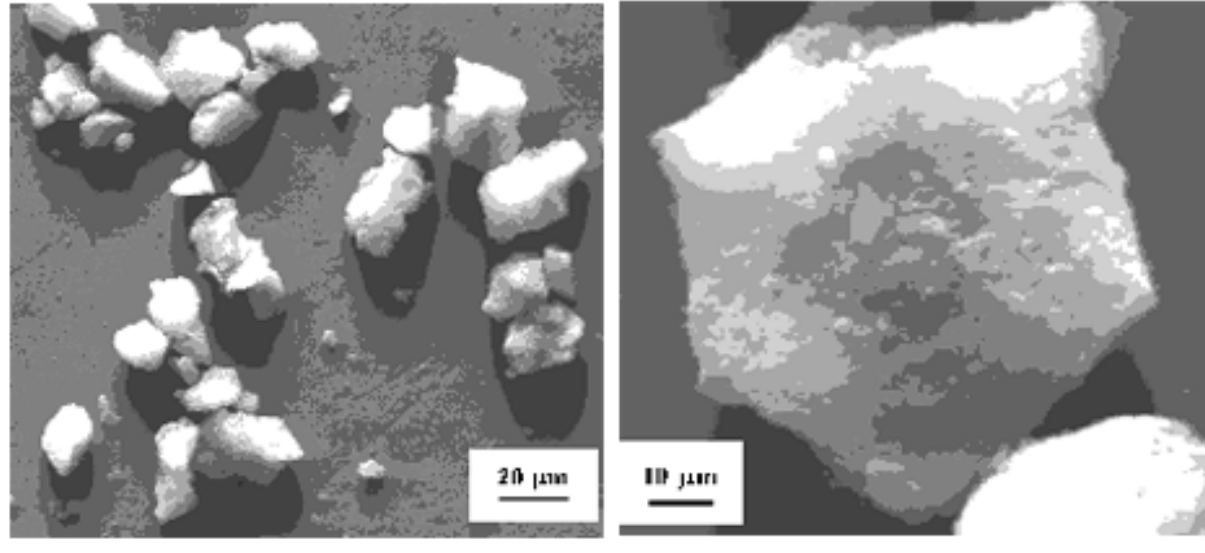
Figure 10. SEM micrographs of the AlSiMCM-41 samples. (a) AlSi MCM-41 (R/24), (b) AlSi MCM-41